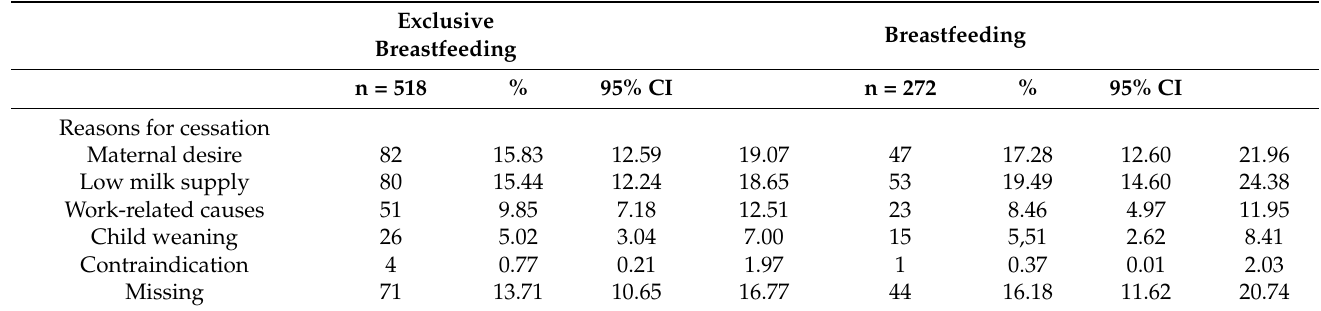
Table 2. Main reasons for cessation of